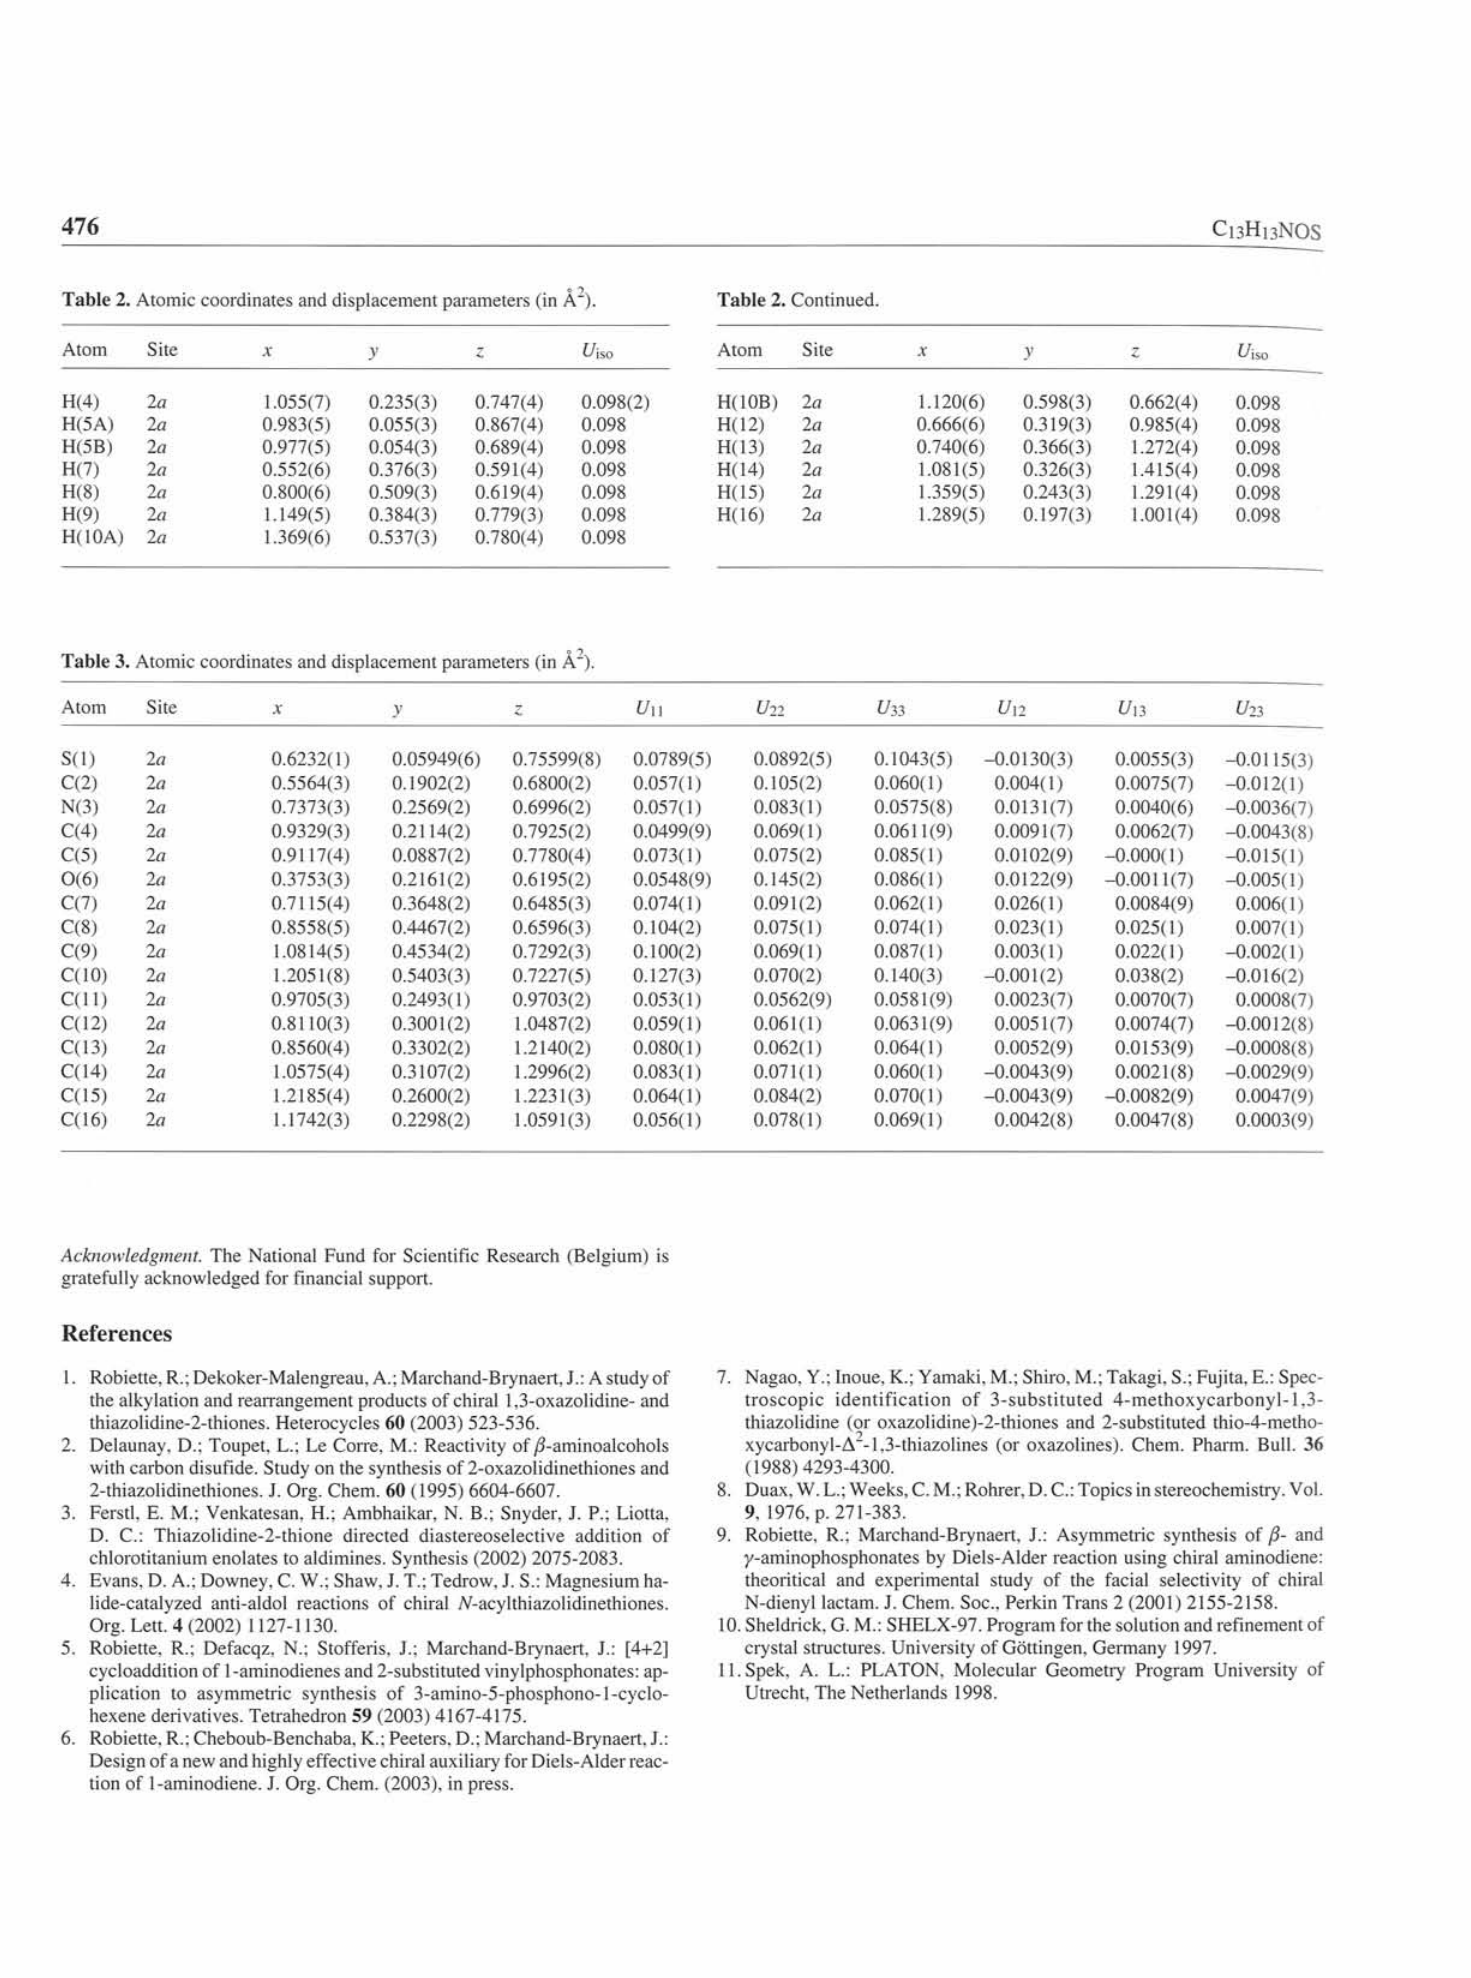
Table 2. Atomic coordinates and displacement parameters (in Â 2 ).